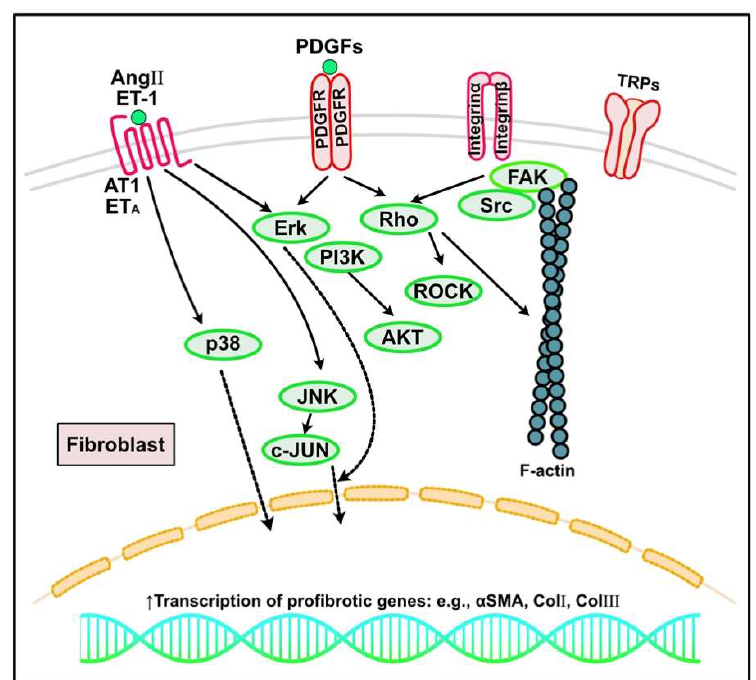
Figure 4. Other signaling pathways regulating cardiac fibrosis. In response to increased mechanical stress and cardiac injury, inflammatory signaling, growth factors (e.g., platelet-derived growth factors (PDGFs)), neurohumoral pathways (e.g., angiotensin (Ang) II, endothelin (ET)-1), and mechanosensitive pathways mediated by integrins and ion channels such as transient receptor potential cation channels (TRPs) can activate fibroblasts into myofibroblasts, leading to excess extracellular matrix protein deposition and cardiac fibrosis. AT1, angiotensin type 1 receptor; PDGFR, PDGF receptor; ERK, extracellular signal regulated kinase; PI3K, phosphoinositide 3-kinase; JNK, c-JUN N-terminal kinase; αSMA, α-smooth muscle actin; ROCK, Rho-associated protein kinases; FAK, fo- cal adhesion kinase.